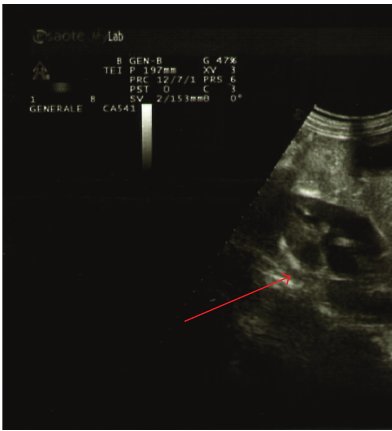
Figure 2: Right hydronephrosis.